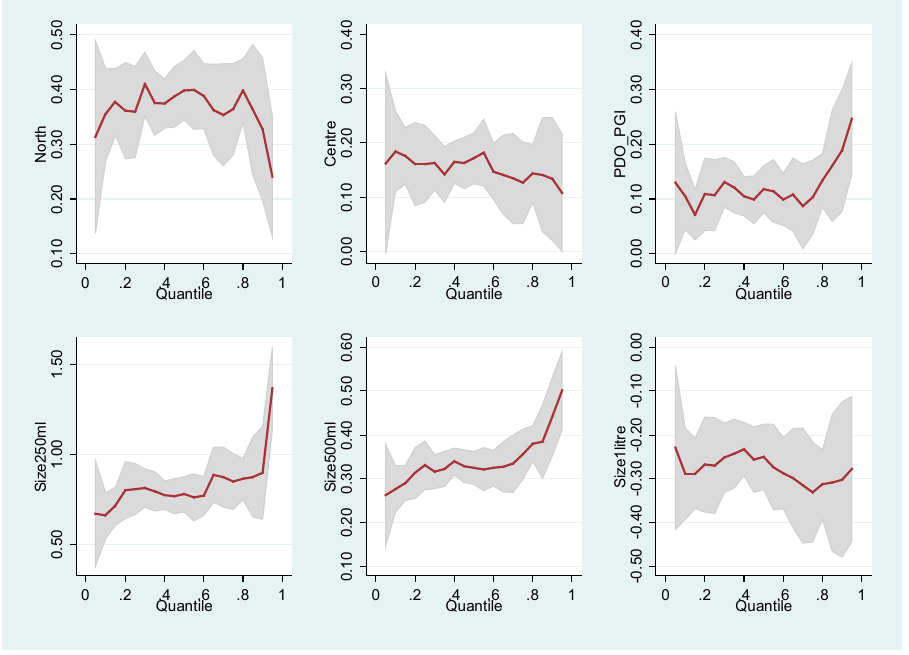
Figure 2. QRM estimates of place of origin, PDO and bottle